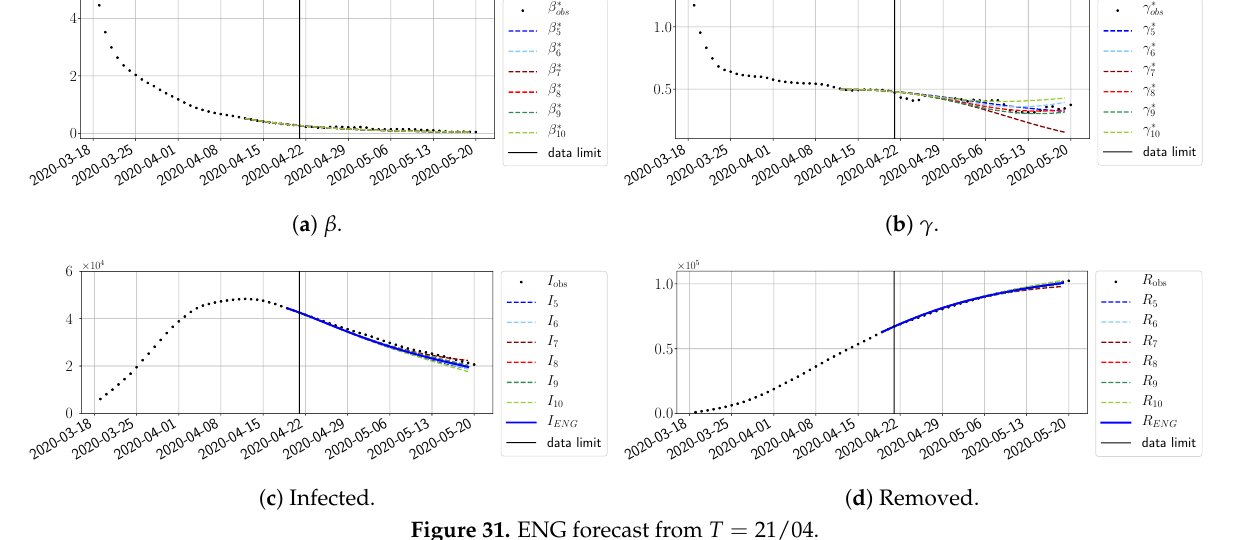
Figure 31. ENG forecast from T = 21/04.